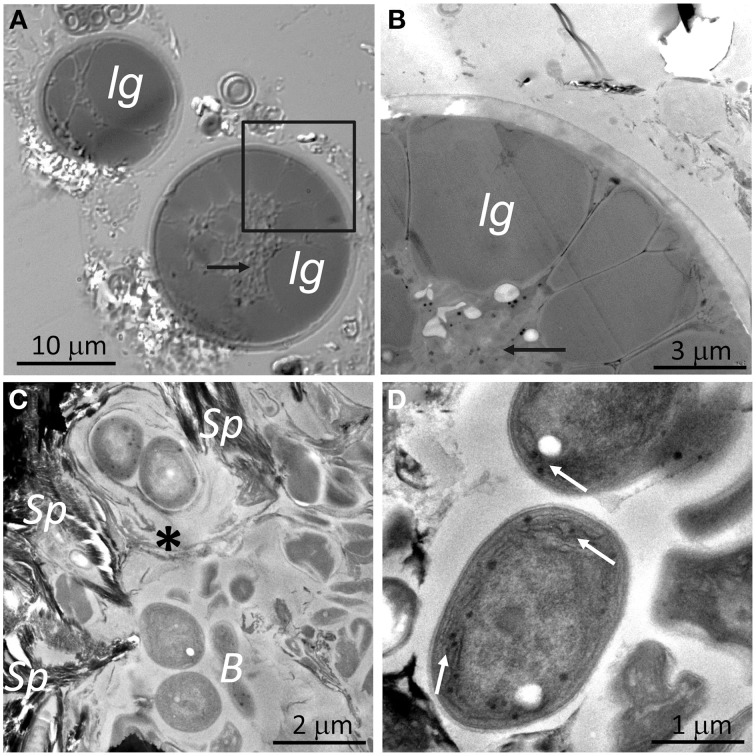
DIC and TEM images of endolithic cells: (A) DIC image and (B) TEM image from zone marked by square in (A) showing algae from the orange zone with lipoidal globules (lg) within the cytoplasm (black arrows). (C) Image showing cyanobacteria from the cryptoendolithic zone surrounded by sheaths of polysaccharides (asterisk) with heterotrophic bacteria (B) and close to sepiolite floccules (Sp). (D) Cyanobacteria from the hypoendolithic habitat with thylakoids (arrows).